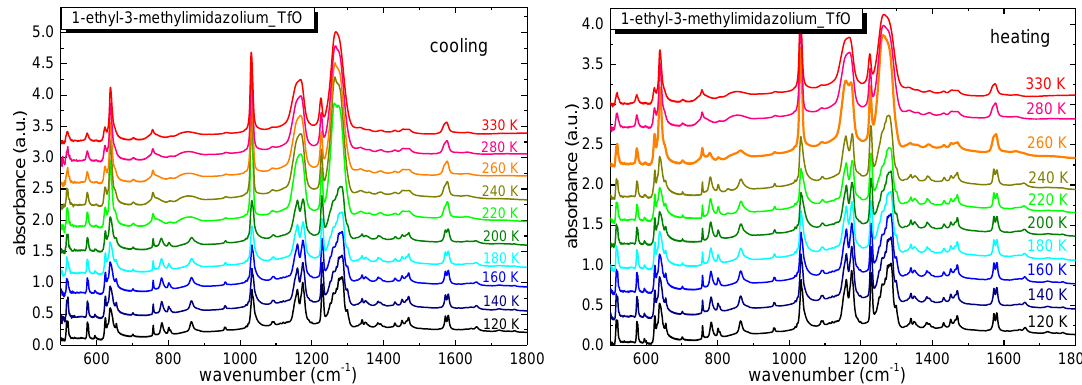
Figure 2. Absorbance of 1-Ethyl-3-methylimidazolium trifluoromethanesulfonate (EMI–TfO) in the mid infrared range, measured on cooling ( left panel ) and subsequent heating ( right panel ).